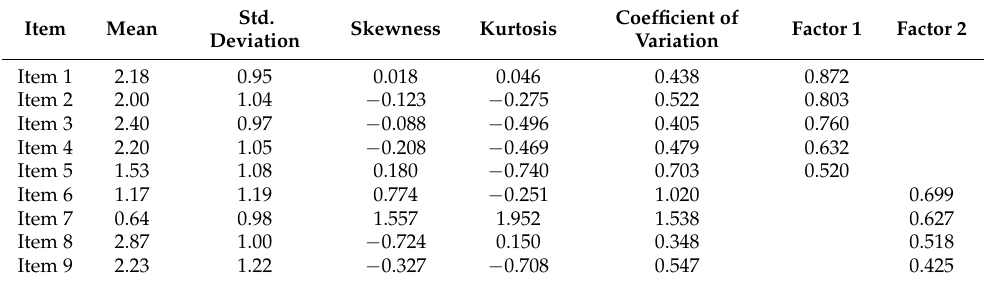
Table 3. Descriptive statistics of the Malay version of the SAVE-9 scale ( n = 203).